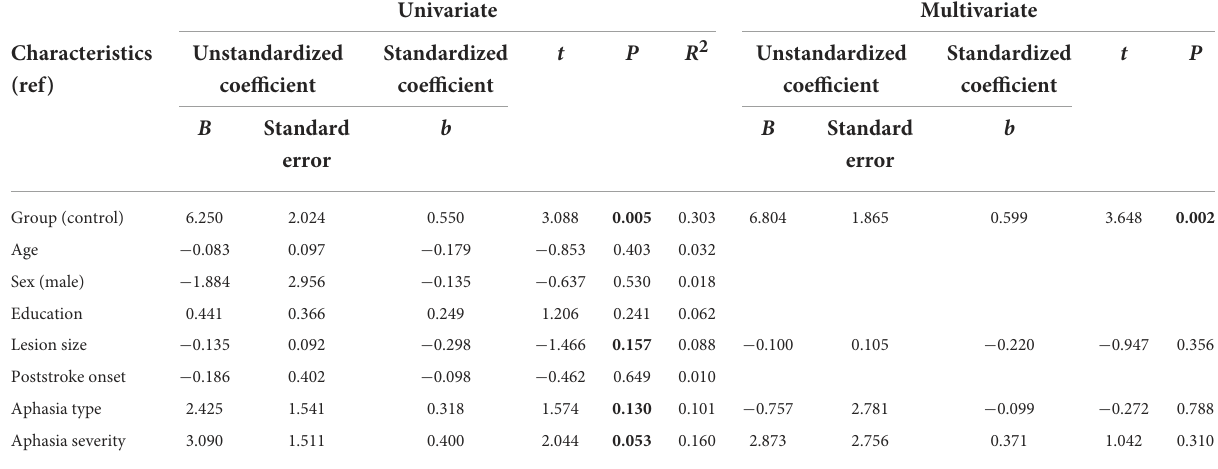
TABLE 4 Linear regression analysis of the relevant factors for the word repetition (the sum of monosyllable and disyllable word